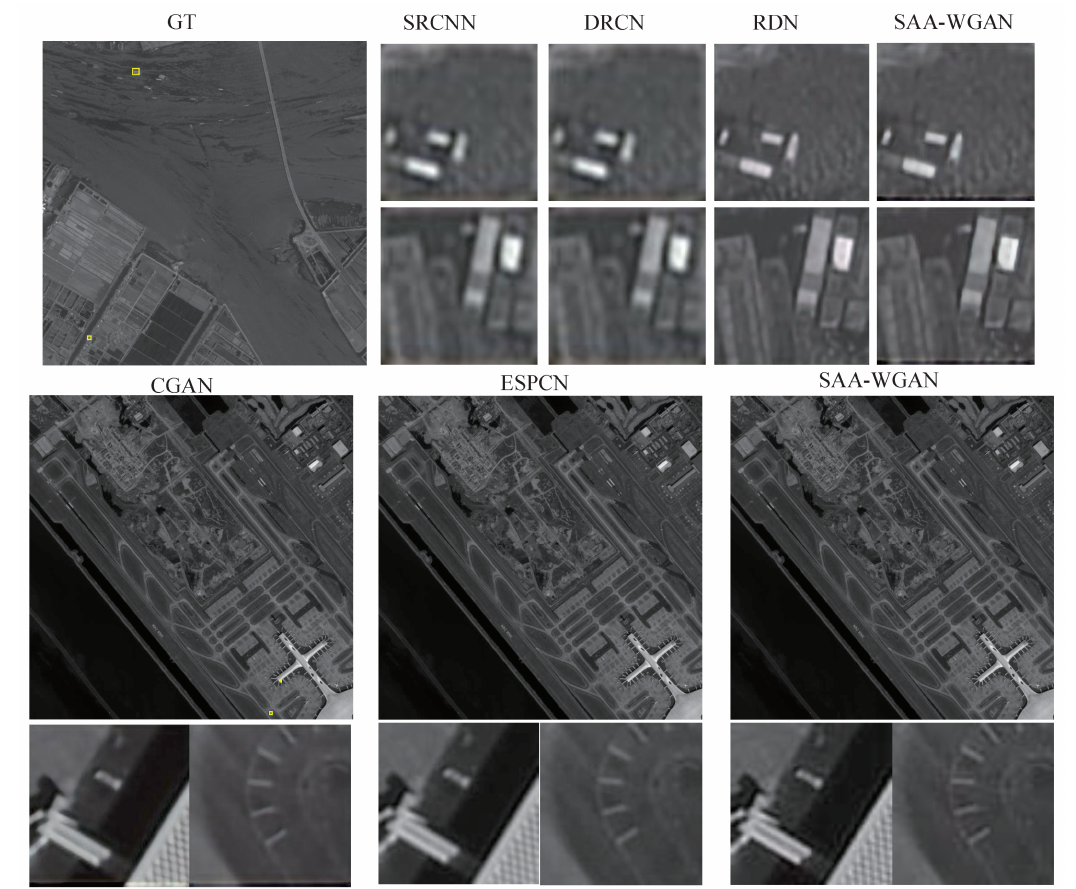
Figure 7. DOTA image for x4 scale